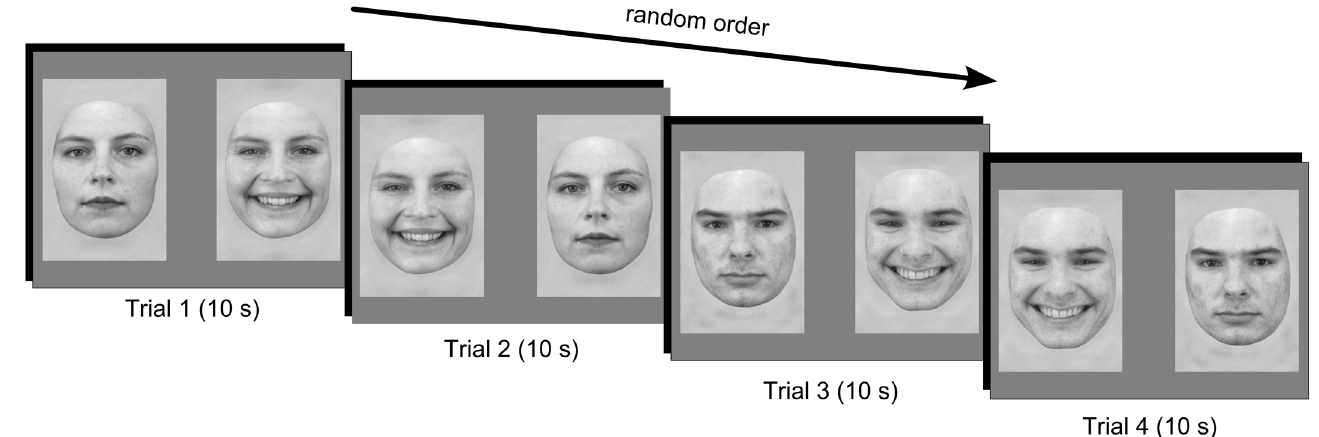
Fig 1. Example session. Each infant saw all four trials, featuring stimuli from one of two stimulus